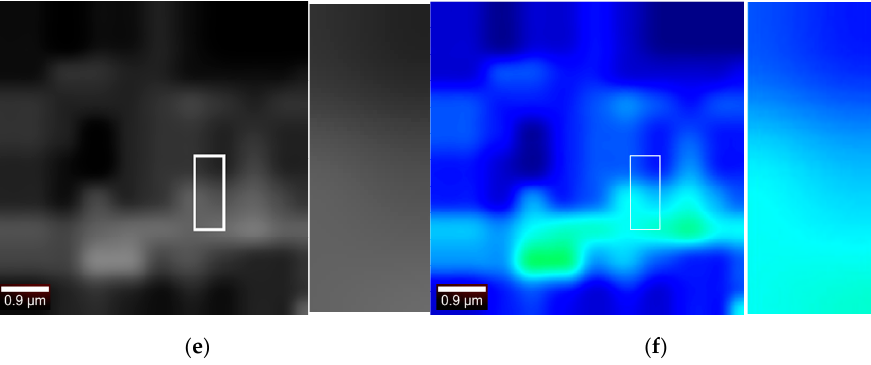
Figure 18. ( a,b ) Imaging in the band 50–2750 (cm − 1 ) ( c,d ) Imaging in the band 2750–3050 (cm − 1 ) Figure 18. ( a , b ) Imaging in the band 50–2750 (cm − 1 ) ( c , d ) Imaging in the band 2750–3050 (cm − 1 ) ( e , f ) ( e,f ) Imaging in the band 3050–3950 (cm − 1 ). Imaging in the band 3050–3950 (cm − 1 ).